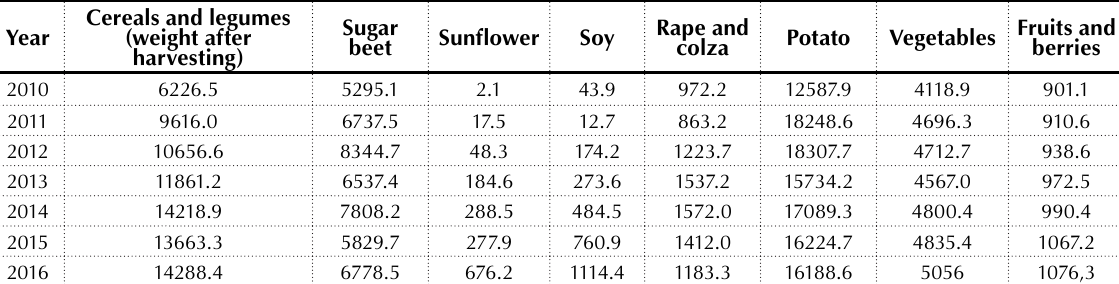
Table 1. Production of the main crops (in centners) in the Lviv region for the period